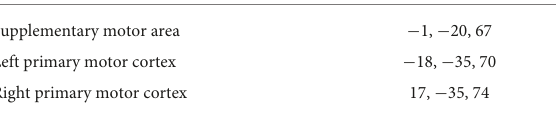
TABLE 3 Coordinates of the three peaks obtained from the sensorimotor network